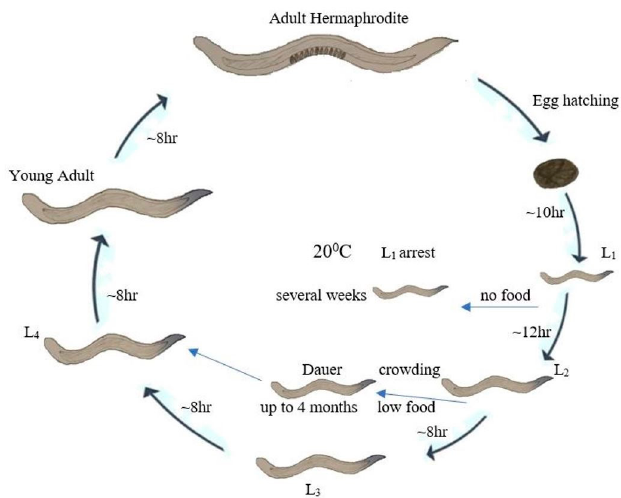
Figure 2. The life cycle of C. elegans . Under normal laboratory conditions, C. elegans goes through four larval stages (L 1 to L 4 ) in approximately 35 h, and L 4 larvae molt into adults, which survive for approximately three weeks. Under unfavorable conditions (low food or crowding), L 1 larvae may proceed through an alternative dauer pathway in which dauer is capable of living for few months and matures to adulthood when the conditions are favorable and proceed to a normal life cycle.